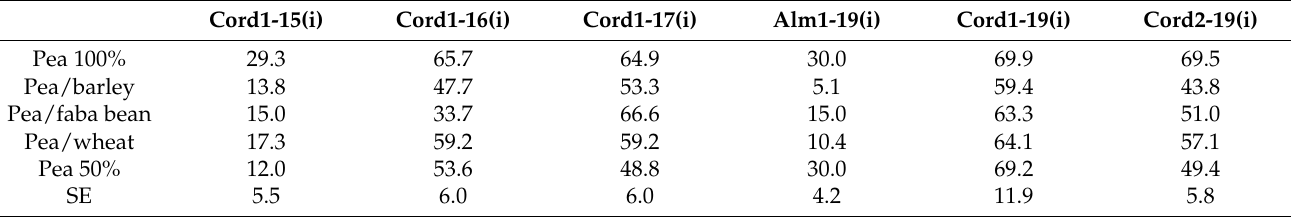
Table 3. Final powdery mildew disease severity (DS) for each treatment of the different intercropping trials carried out (SE: standard